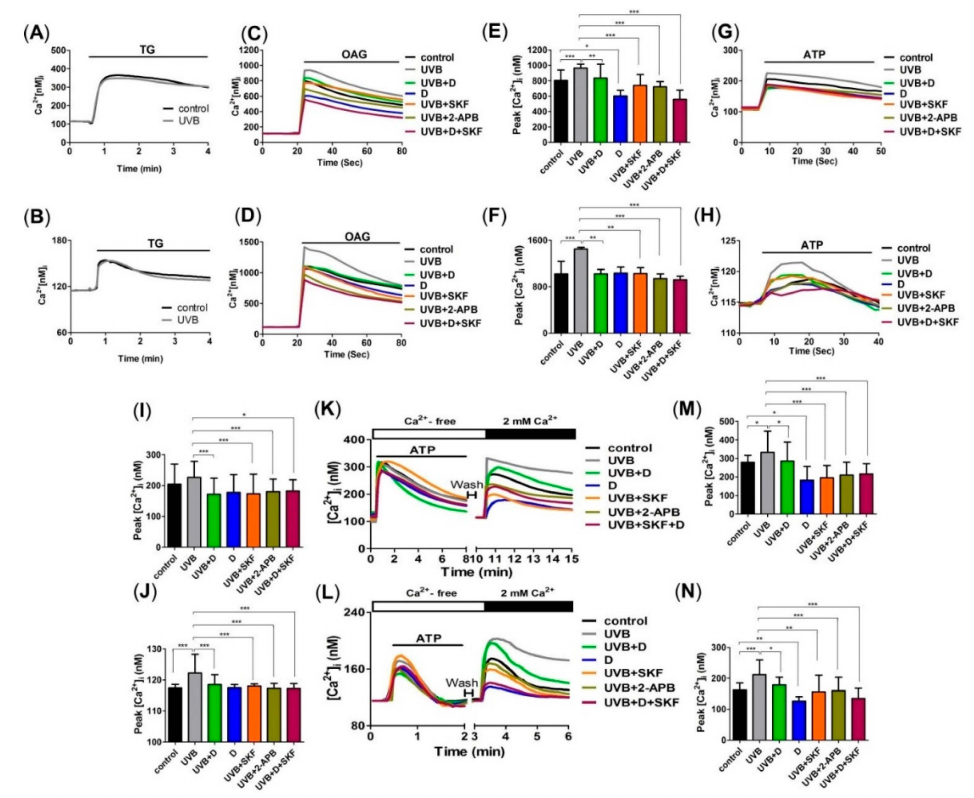
Figure 3. Derinat reduced UVB activated Ca 2+ signaling in skin cells. Ca 2+ imaging analysis of the thapsigargin (TG)-induced Ca 2+ response after the application of 20 nM TG (small black